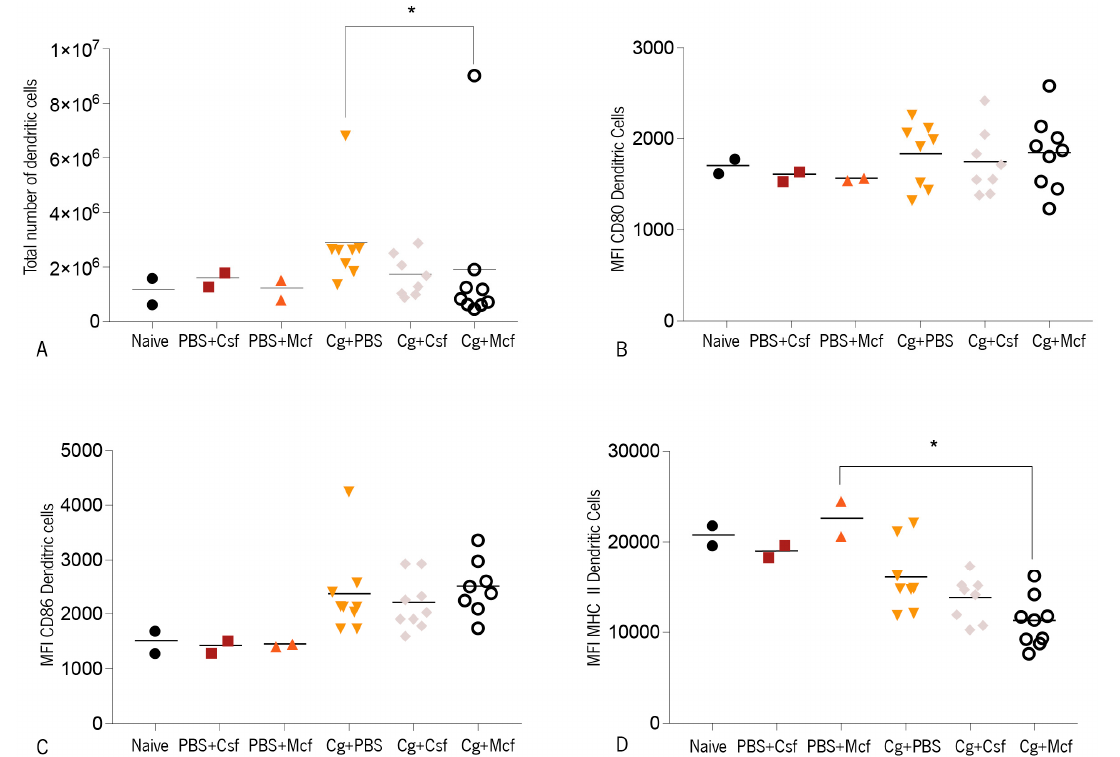
Figure 4. CD1 mice were challenged intravenously with 1 × 10 8 biofilm cells and then treated with PBS, caspofungin (Csf), or micafungin (Mcf). The obtained results are displayed as ( A ) total number of dendritic cells or mean fluorescence intensities (MFI) due to antibody staining against ( B ) CD80, ( C ) CD86, and ( D ) MHC class II on the surface of dendritic cells. The numbers of animals used were: controls (naïve; PBS + Csf; PBS + Mcf), n = 2; Cg + Csf, n = 8; Cg + Mcf, n = 8. Statistical differences among infected groups were evaluated using Kruskal–Wallis (overall ANOVA P < 0.05), post hoc Sidak’s, and Dunn’s multiple comparisons tests (* P > 0.05). Cg— Candida glabrata ATCC2001. * P < 0.05.